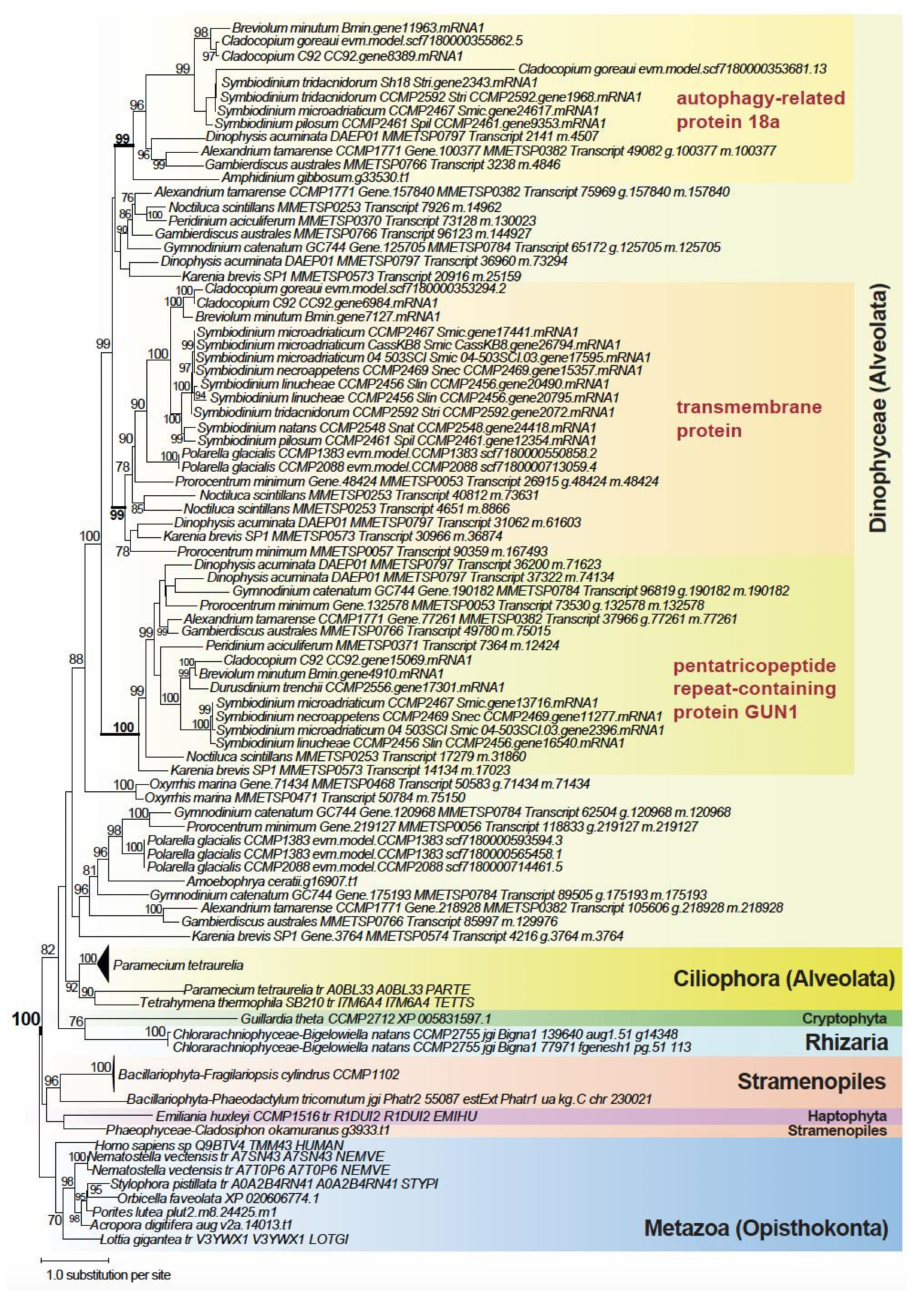
Figure 5. Maximum likelihood protein tree showing vertical inheritance and gene expansion among dinoflagellates, with distinct clades containing the autophagy-related protein 18a, the transmembrane protein 43, and the pentatricopeptide repeat-containing protein GUN1. The ultrafast bootstrap support of IQ-TREE2 is shown at each internal node; only values ≥ 70% are shown. Unit of branch length is the number of substitutions per